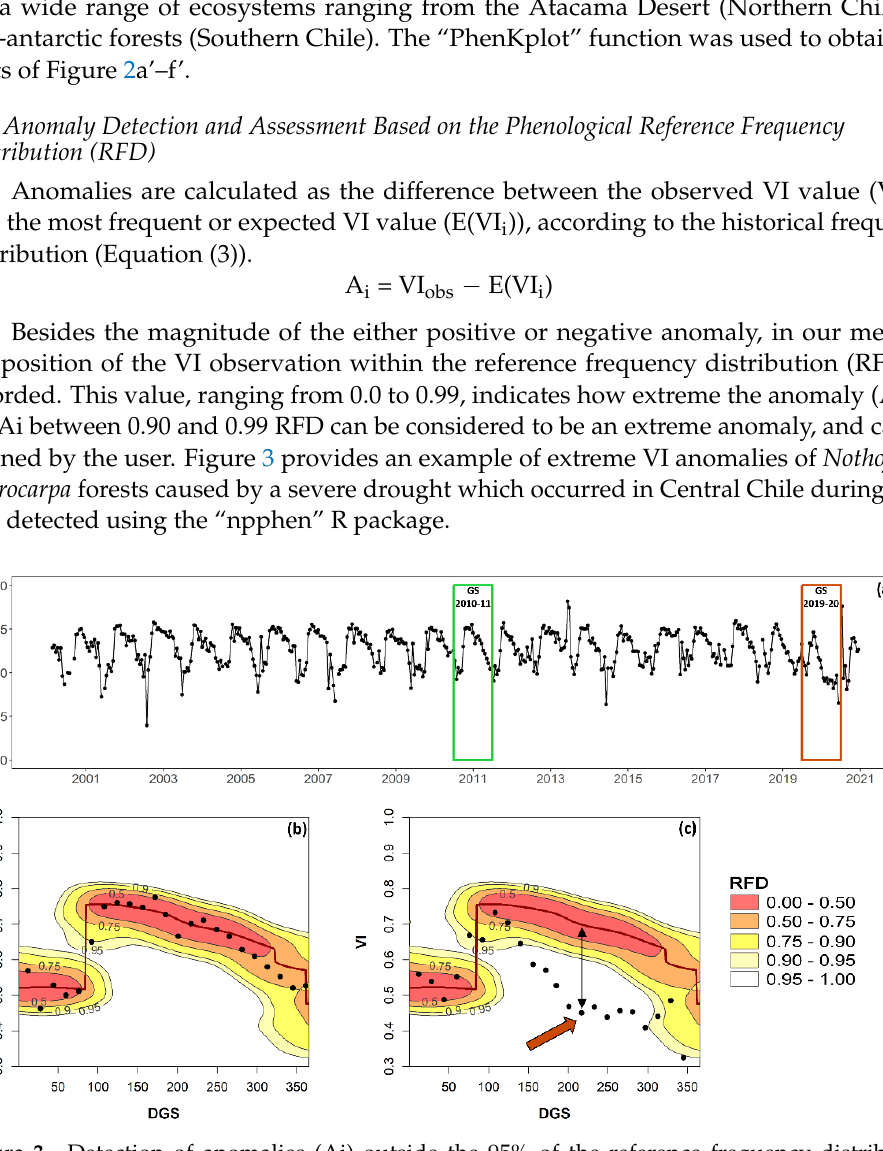
Figure 3. Detection of anomalies (Ai) outside the 95% of the reference frequency distribution (RFD >= 0.95) using the “npphen” R package. ( a ) A vegetation index (VI) time series of a Nothofagus macrocarpa forest in Central Chile where a severe drought occurred during the growing season (GS) 2019–20 (red box). ( b ) The reference frequency distribution (RFD) of all VI observations is calculated by means of kernel density estimations in the VI–DGS space. Black dots are VI observations of the GS 2010–11 with all records falling inside RFD < 0.95, i.e., a normal year. ( c ) VI observations during the GS 2019–20 showing values at RFD >= 0.95, i.e., with extreme negative VI anomalies as a consequence of the severe